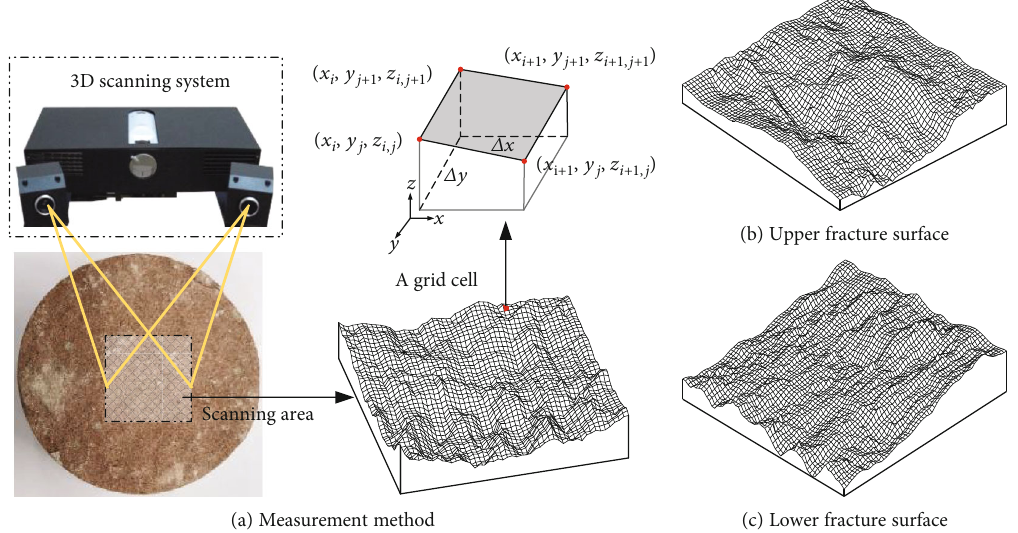
Figure 5: Roughness test of rock specimen fracture surfaces.